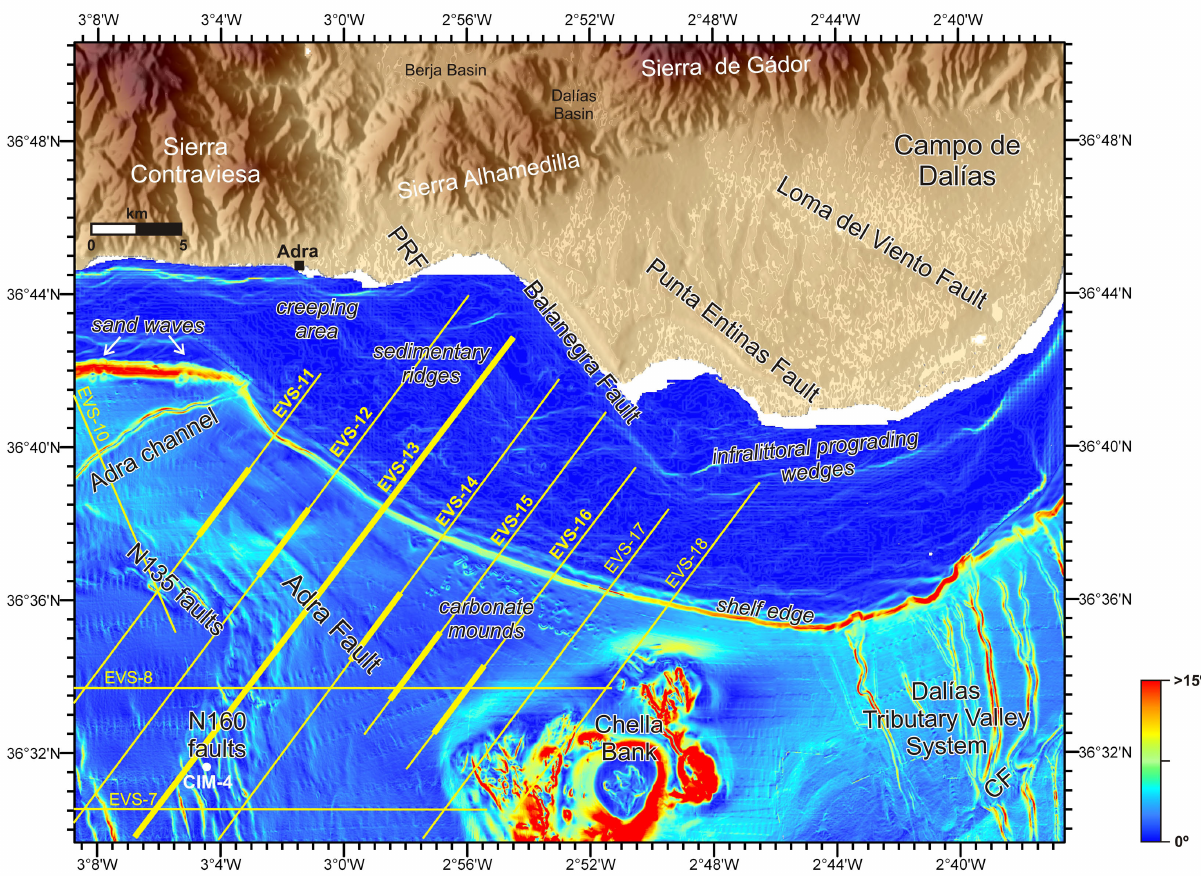
Fig. 3. Slope map of the Adra–Almer´ıa shelf and upper slope with the location of the main features (illumination from the NE, scale in degrees). Sparker profiles acquired during the EVENT-SHELF cruise across the Adra Fault are depicted by yellow lines. Thicker yellow lines correspond to profiles presented in Figs. 4 and 6. White dot locates core CIM-4 presented in Fig. 5. PRF: Puente del R´ıo Fault; CF: Carboneras